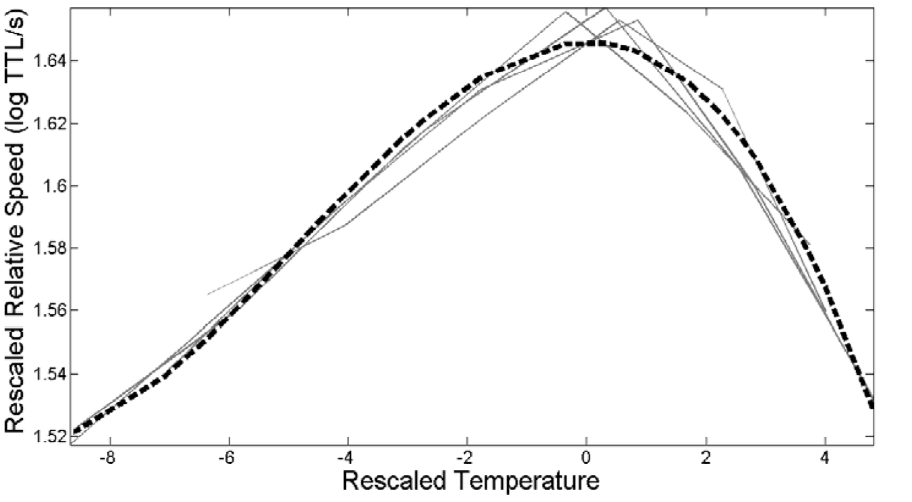
Figure 1. Rescaled thermal performance curves for swimming speed in each treatment with fitted common template shape. Common template shape z(T) is represented by a dashed line nad the treatments by solid lines. Each thermal performance curve of a treatment (i) and temperature were standardized with respect to the estimates of height (h), location (m; T opt ), and width (w) parameters from the fit to model. Rescaled optimum temperature T opt =0. (see [46,51]). Swimming z(T) =1.6458–0.004T 2 –0.00023982T 3 + 0.000003493T 4